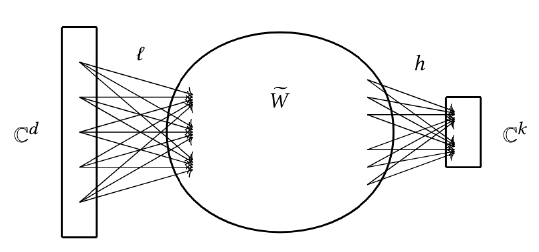
Figure 10. An illustration of a double-framed thin quiver representation ( (cid:96) , (cid:101) W , h ) . The boxes define the vector spaces of the framing and co-framing, given by C d and C k ,